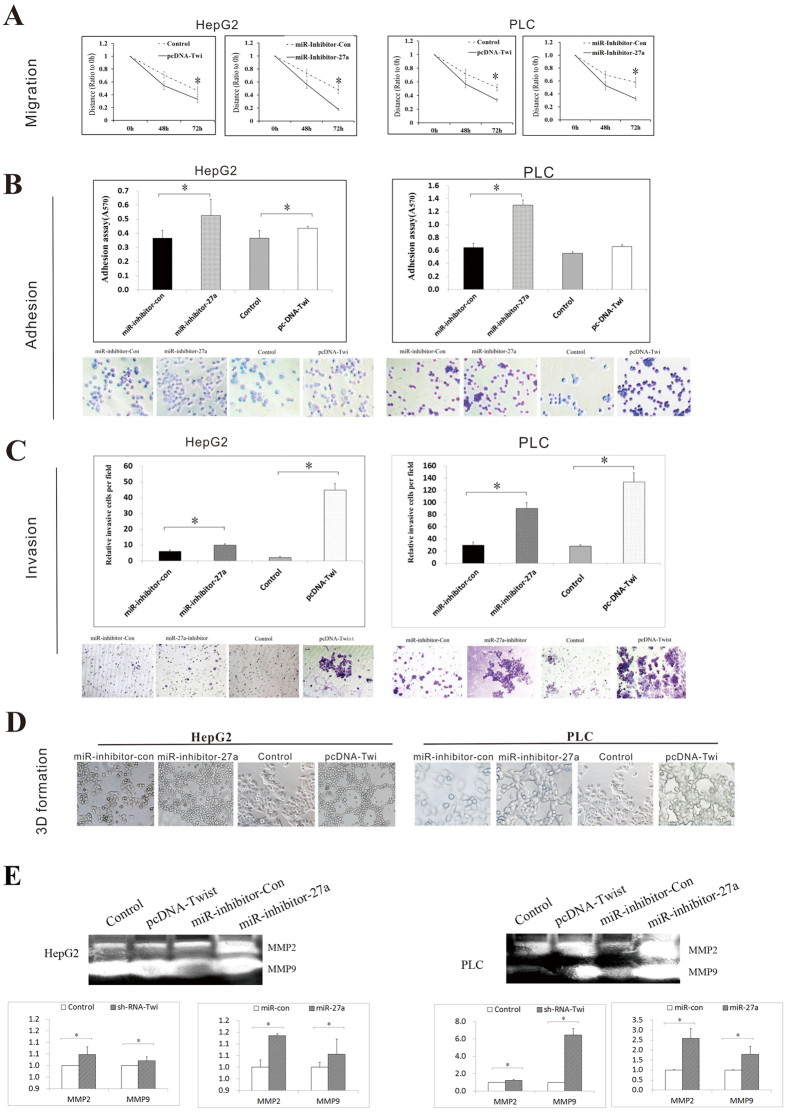
Down-regulation of miR-27a-3p enhanced aggressive phenotypes and VM formation.HepG2 and PLC cells were transfected with miArrest™ miRNA Inhibitor Expression Clone miR-27a-3p (referred to as miR-inhibitor-27a) or pcDNA3-Twist-1 (referred to as pcDNA-Twi). The effects of miR-inhibitor-27a and pcDNA3-Twist-1 on cell migration, invasion and adhesion and capillary tube formation were evaluated via (A) a wound healing assay, (B) a cell adhesion assay, (C) a transwell invasion assay, (D) a 3D VM formation assay, and (E) gelatin zymography.